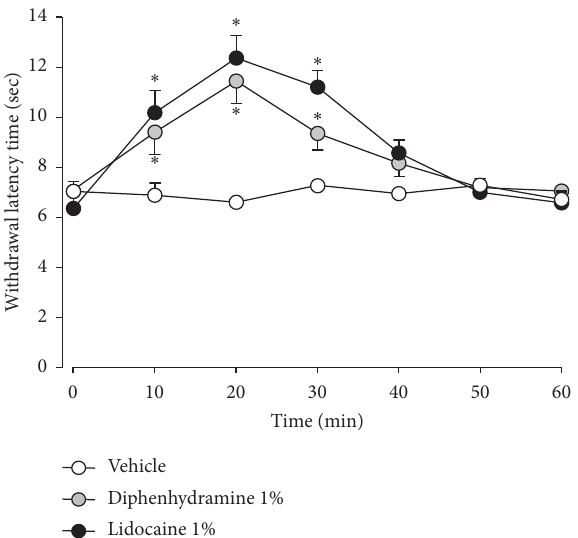
Figure 1: Antinociceptive effects of diphenhydramine on the withdrawal latency time after a subcutaneous injection into the plantar surface of the right hind paw. The injection of 0.5% or 1% diphenhydramine produced a significant inhibition in withdrawal latency compared with the vehicle treatment. The values shown are the mean ± SEM, and there were seven animals in each group. ∗ P < 0 . 05, vehicle vs. diphenhydramine.